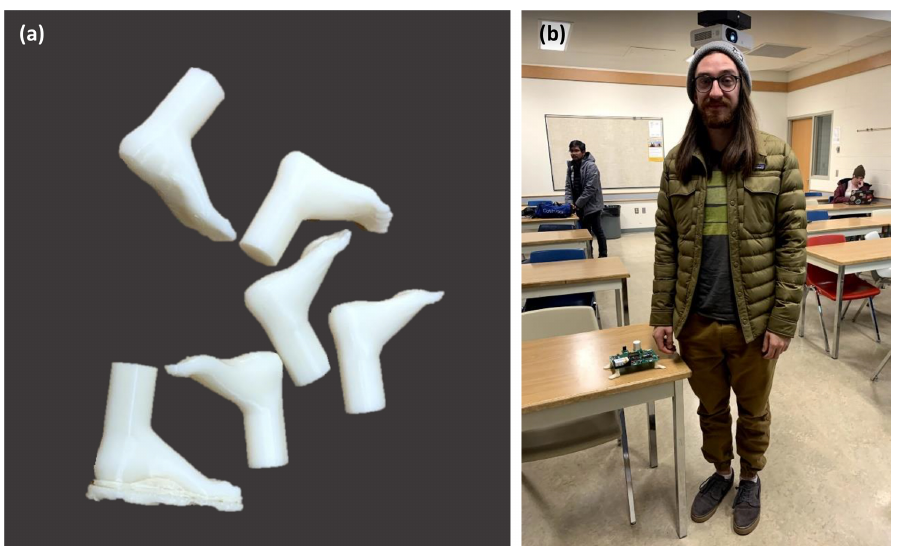
Figure 10. (a) Example of 3D printed feet to be glued on the bottom of a PCB. The 3D printed foot nearest the bottom of the image has a 3D printed “raft” that has not been removed. The raft is placed on the 3D printer build platform to ensure that the deposited plastic sticks to a substrate. (b) Student next to a PCB exhibiting feet glued on the